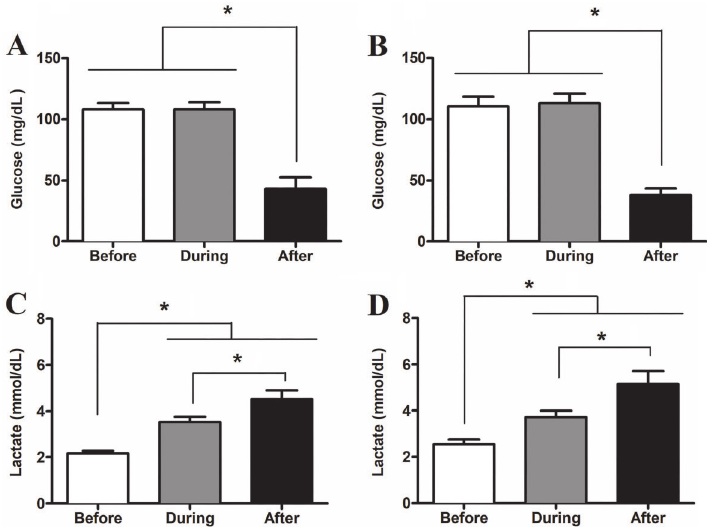
Figure 1. Serum glucose ( A and B ) and lactate ( C and D ) concentration measured before, during (50 min), and after the exhaustive test. Data for ET groups (trained animals subjected to an exhaustive test without supplementation) are shown in graphs A and C . Data for ET-AG groups (trained animals subjected to exhaustive test and supplemented with alanyl-glutamine) are shown in graphs B and D . The data (n=8) are reported as means ± SD. *P o 0.05, ANOVA followed by Bonferroni post hoc